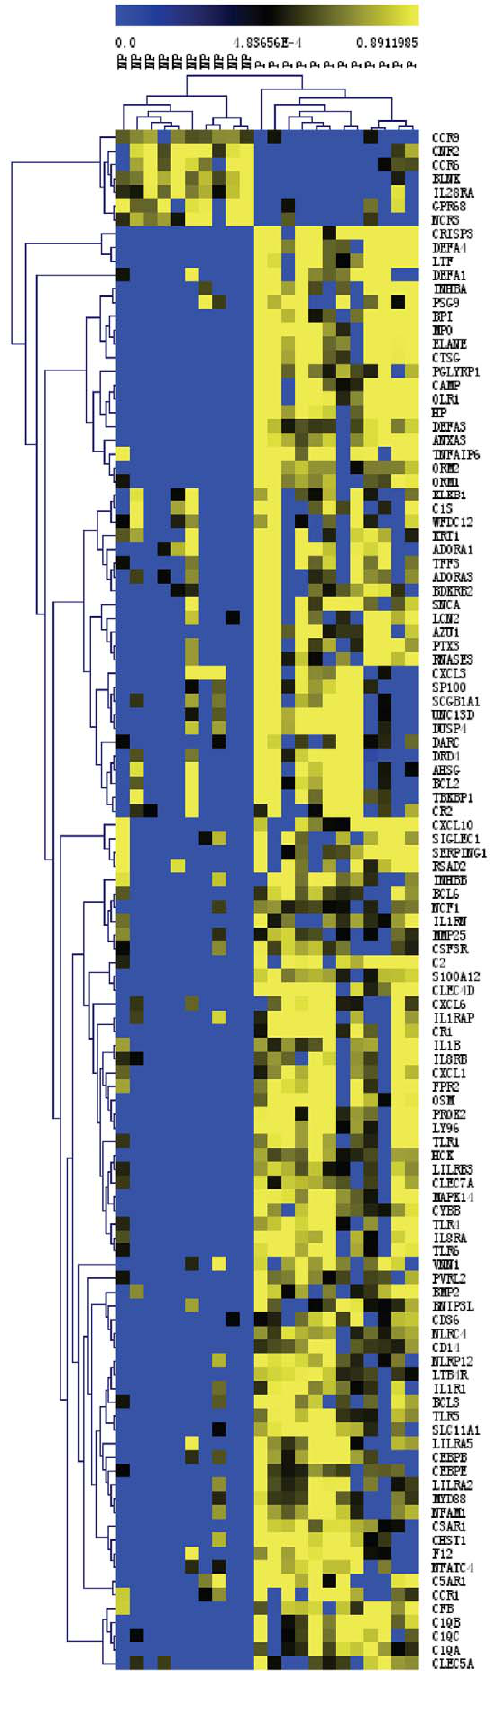
Figure 3. Hierarchical clustering of differentially expressed immune defense genes (GO: 0006952) in pregnant versus nonpregnant women. This figure presents the hierarchical clustering of 112 differentially expressed immune defense genes in third trimester women versus nonpregnant women (reference group) at the beginning and end of the controlled feeding study. Color scheme: blue represents low expression and yellow represents high expression. n=12 for pregnant women; n=10 for nonpregnant women. Analyzed with Euclidean distances using MultiExperiment